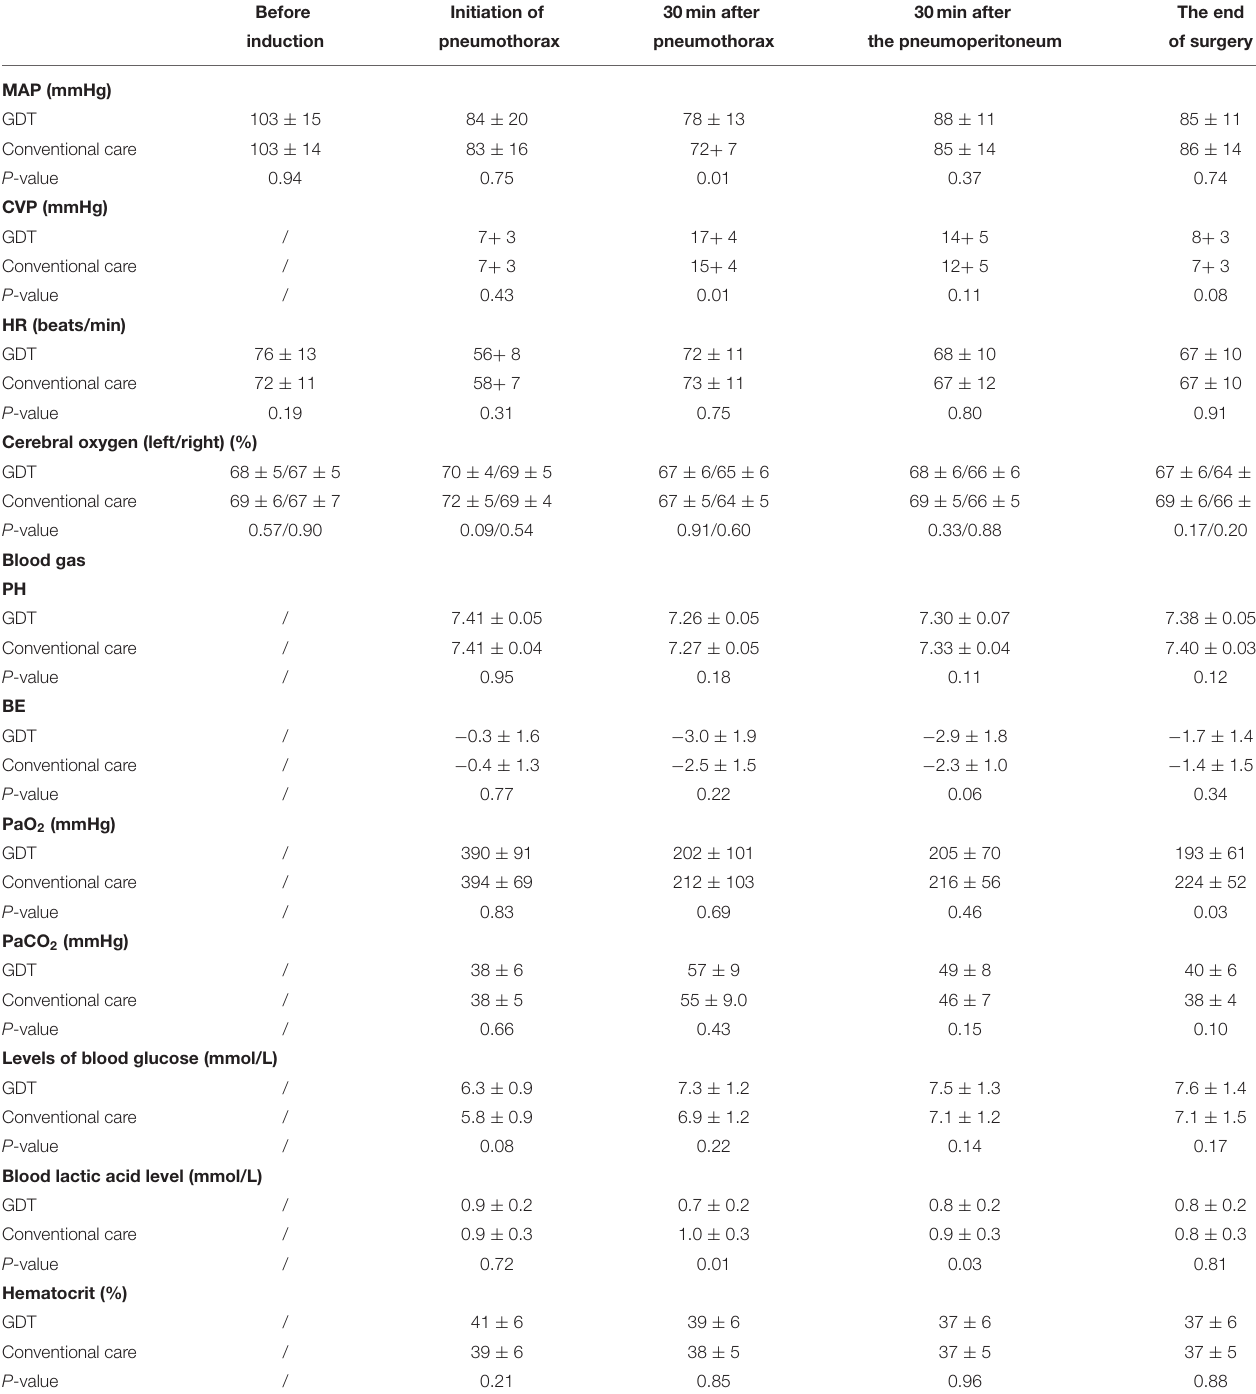
TABLE 4 | Hemodynamic, cerebral oxygen and blood gas parameters during operation. Before Initiation of 30min after 30min after The end induction pneumothorax pneumothorax the pneumoperitoneum of